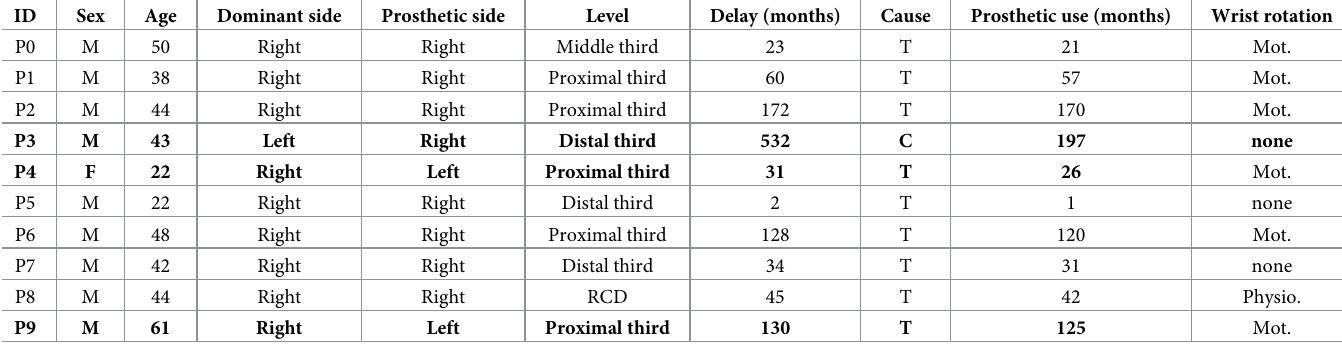
Table 1. Main clinical